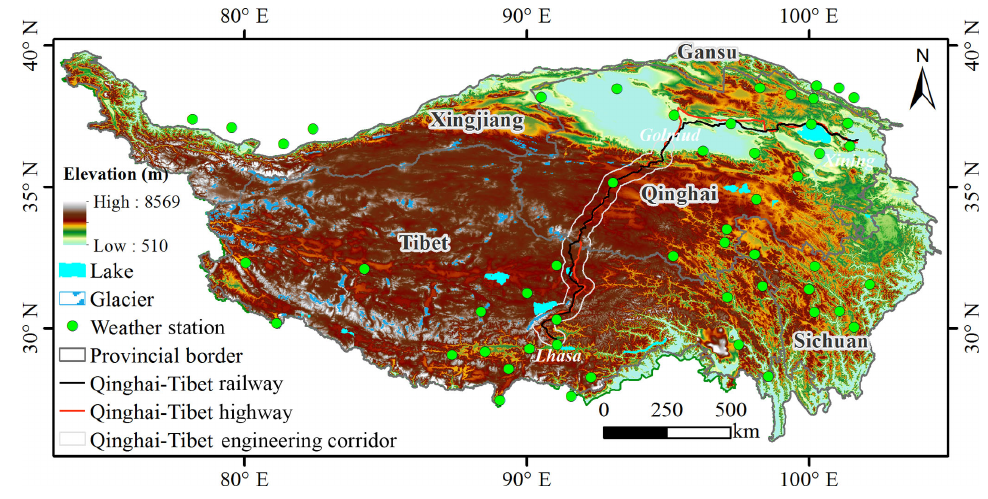
Figure 1. Map of the data location over the